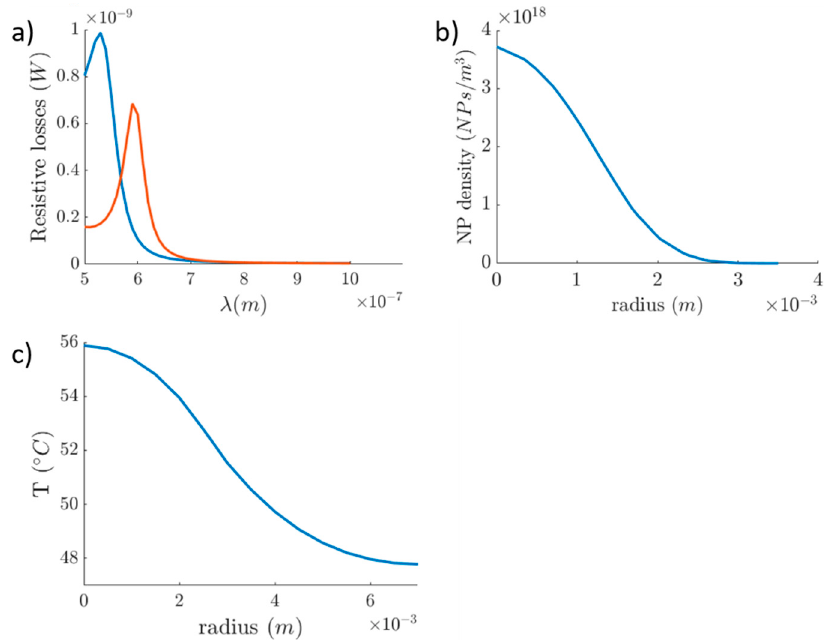
Figure 12. Resonant wavelength of two different size nanoparticles. ( a ) The blue line corresponds to the 40 nm AuNP and the orange line to the 30 nm Au-SiNP. ( b ) Distribution of NPs inside the tumorous tissue 1 h after the injection in the center of the tumor. ( c ) Temperature rise during the first 10 min of NP laser-induced heating.